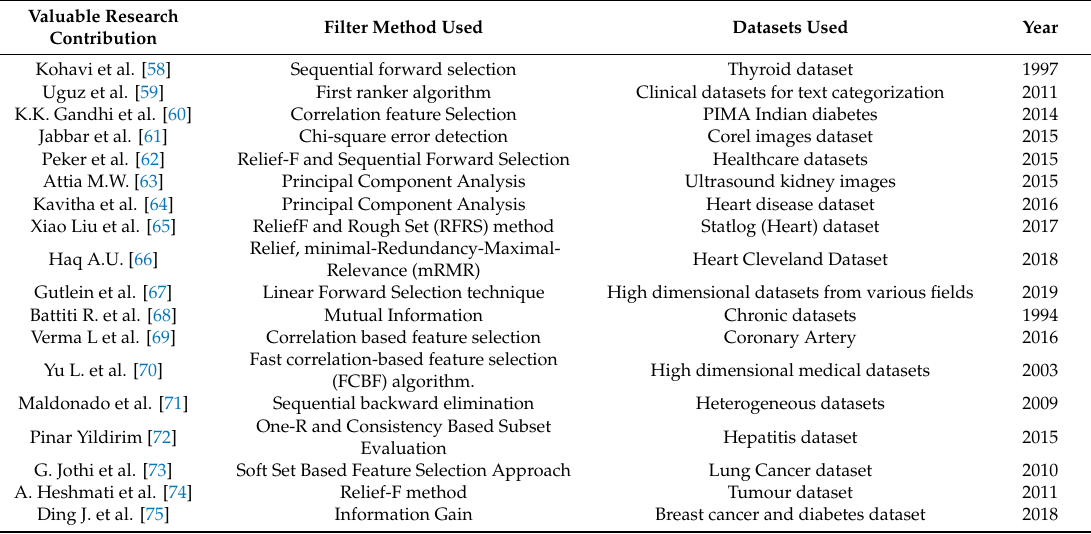
Table 2. An outline of relevant study on wrapper based attribute